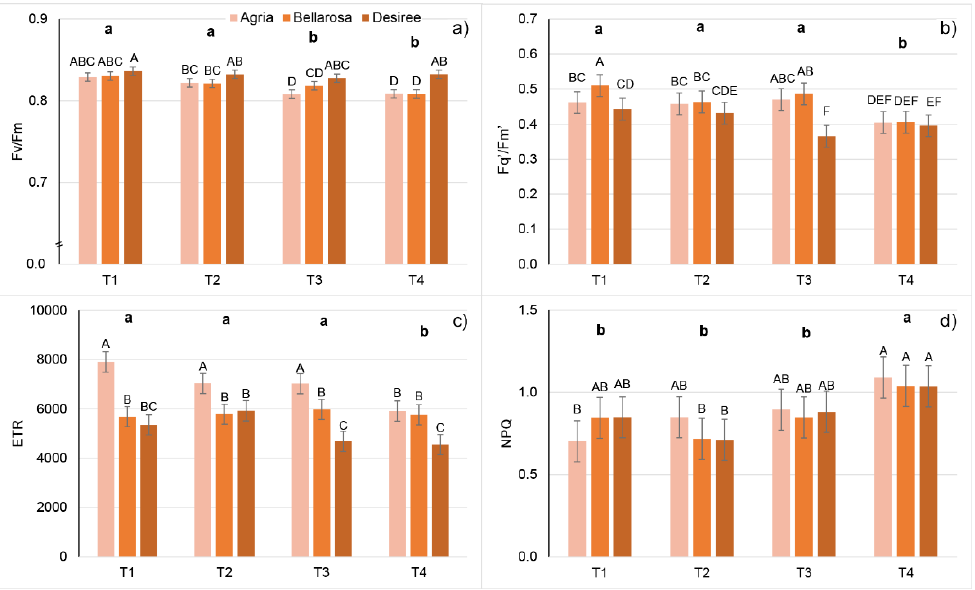
Figure 4. Mean values and double standard error of the mean for the chlorophyll fluorescence traits: ( a ) maximum quantum yield of PSII (F v /F m ), ( b ) effective quantum yield of PSII (F q ’/F m ’), ( c ) non-photochemical quenching (NPQ), and ( d ) electron transport rate (ETR) of potato cultivars (Agria, Bellarosa, and Desiree) after ten days of growth in four different temperature treatments: 20/15 °C (T1), 25/20 °C (T2), 30/25 °C (T3), and 35/30 °C (T4). Different uppercase letters indicate significant differences for cultivar × treatment interaction; different lowercase letters in bold indicate significant differences between temperature treatments (Tukey’s HSD test p < 0.05).